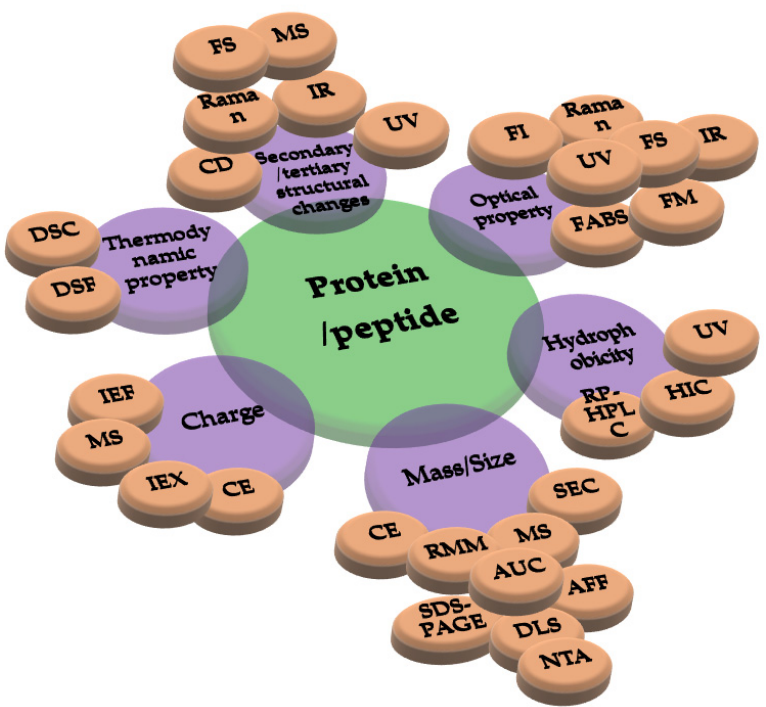
Figure 9. Different analytical techniques that are currently applied for characterization of protein and peptide drugs. Abbreviations: AUC: analytical ultracentrifugation, DSC: differential scanning calorimetry, CE: Capillary electrophoresis, CD: circular dichroism, DSF: differential scanning fluorimetry, UV: ultraviolet, DLS: dynamic light scattering, FAPS: fluorescence-activated particle sorter, AFF: asymmetrical flow-field flow fractionation, NTA: nanoparticle tracking analysis, RMM: resonant mass measurement, SEC: size-exclusion chromatography, SDS-PAGE: sodium dodecyl sulfate-polyacrylamide gel electrophoresis, MS: mass spectrometry, RP-HPLC: reversed-phase high-performance liquid chromatography, IEF: isoelectric focusing, IEX: ion exchange chromatography, FM: Fluorescence microspcopy, FI: Fluorescence imaging, and FS: Fluorescence signal.